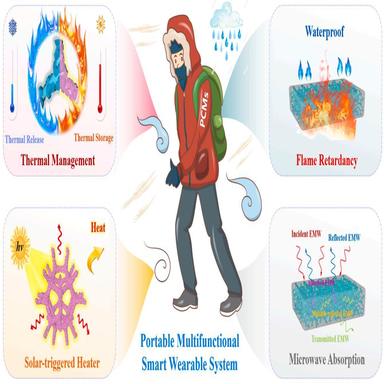
Schematic illustration of potable multifunctional smart wearable system integrating waterproof, flame retardancy and microwave absorption for lighttriggered thermal management.